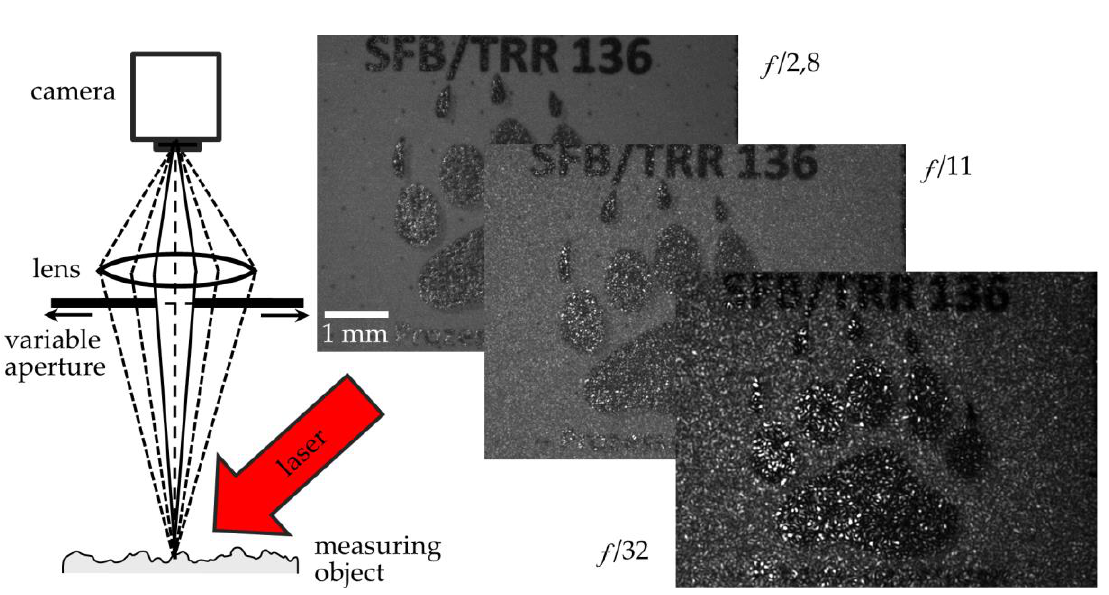
Figure 2. Image of the printed logo of the Transregional Collaborative Research Center and the behavior of the subjective speckle pattern when decreasing the aperture (increasing the f -number).